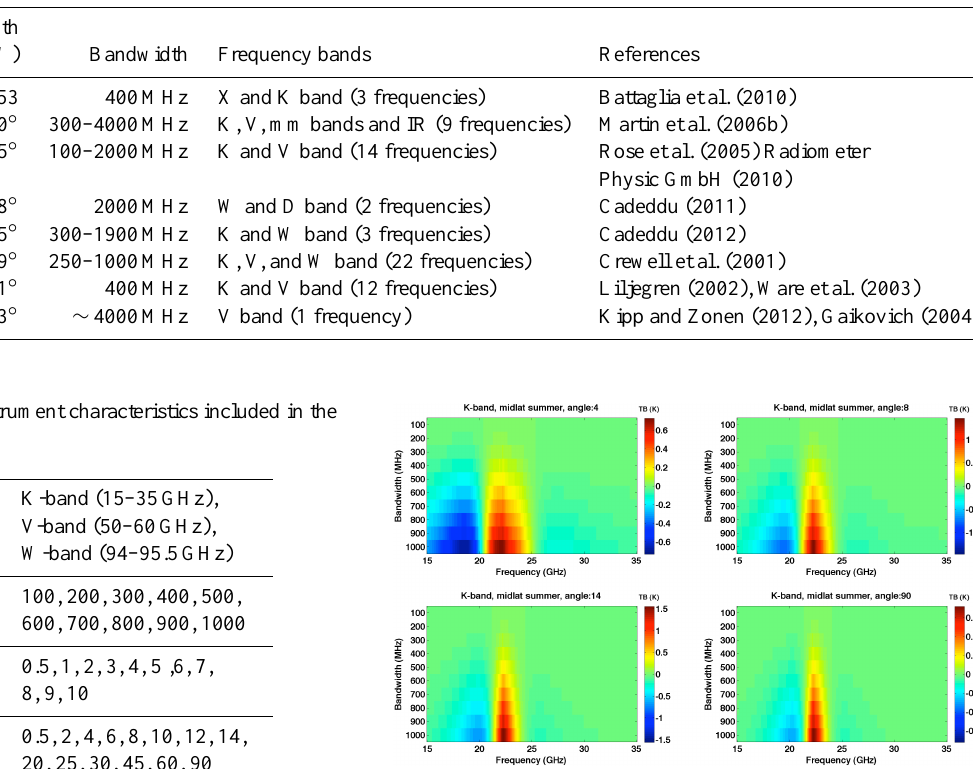
Table 1. A sample of current commercial and experimental radiometers that inspired the instrument design characteristics included in this study, where HPFW is half power full width.